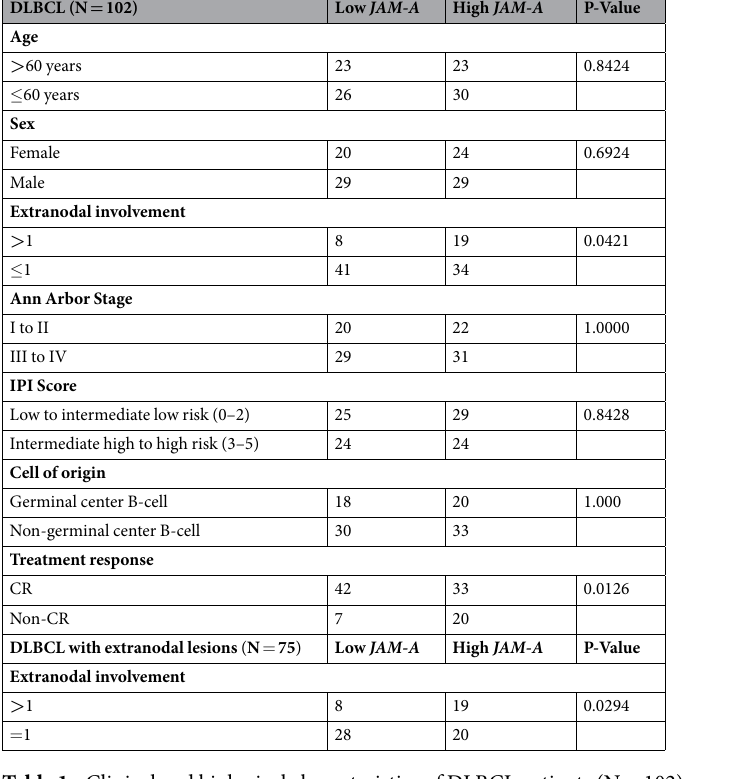
Table 1. Clinical and biological characteristics of DLBCL patients (N =